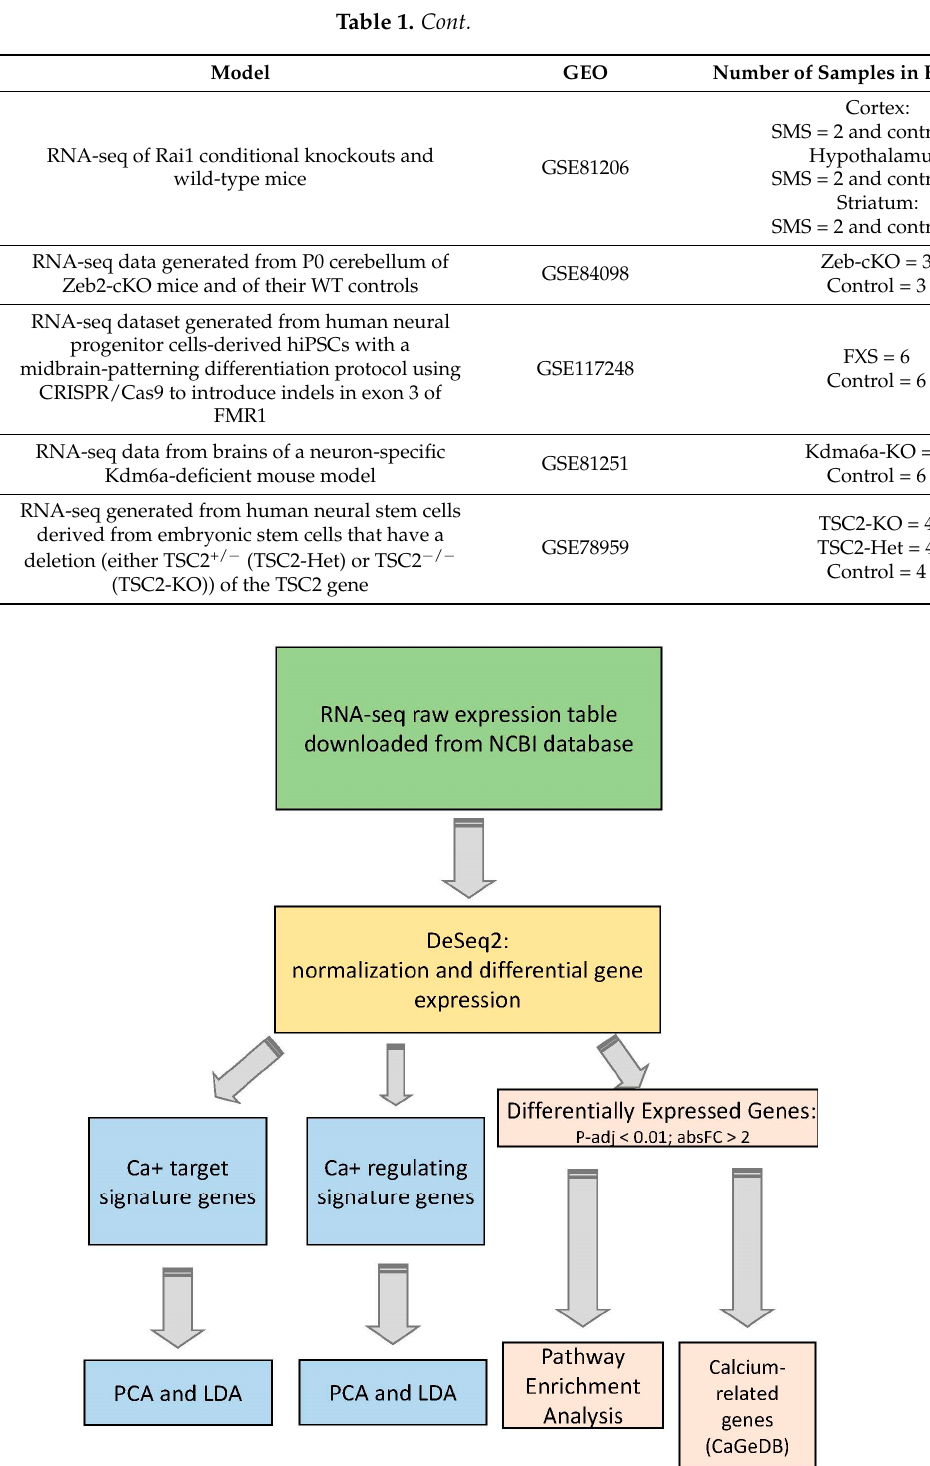
Figure 1. A schematic presentation of analysis steps for each dataset.